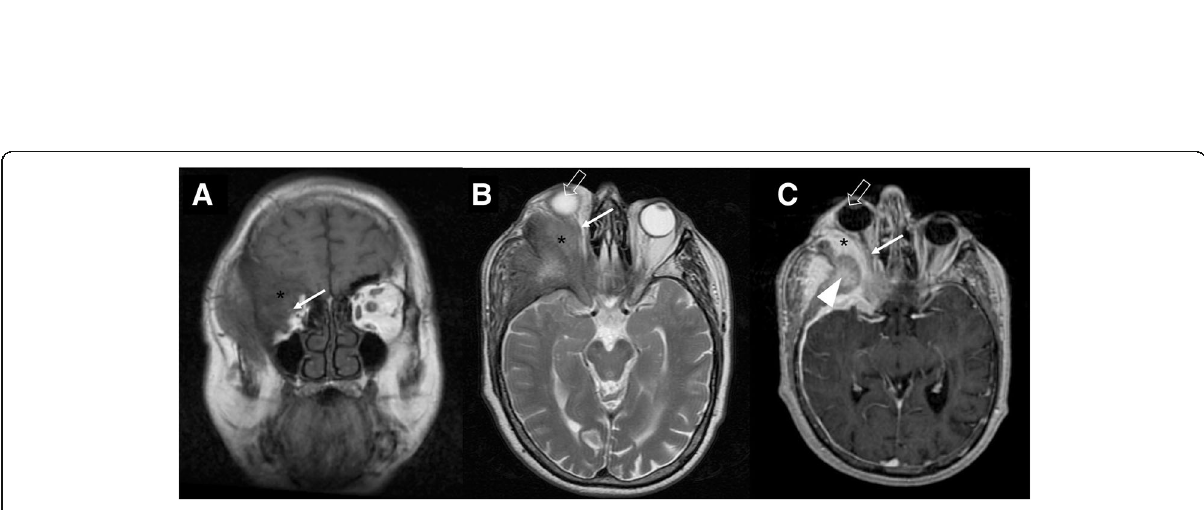
Fig. 23 Sphenoid wing meningioma. MRI T1-weighted coronal image ( a ), T2-weighted ( b ), and T1-post gadolinium ( c ) axial images. A large mass with avid enhancement is visible, suggestive for meningioma of the right sphenoid wing (asterisks) with orbital involvement, displacement of the optic nerve (arrows), and the globe (empty arrows). Signs of hyperostosis are also evident (arrowhead)